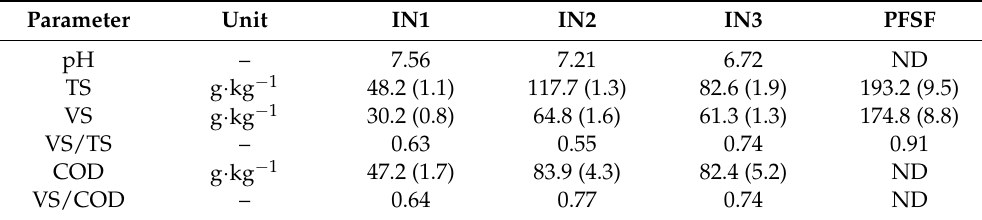
Table 1. The digestate IN1 was obtained from an anaerobic digester treating the anaerobic activated sludge in the WWTP of Garmerwolde, Groningen. The digestate IN2 was collected from an anaerobic bioreactor treating the organic fraction of municipal solid waste (MSW) in the MSW treatment plant of Attero in Groningen. The digestate IN3 was obtained from a livestock farm digester in Groningen treating cow manure. All of the digesters have been stably operated for many years. Table 1. Characteristics of the inoculums and substrate used in the batch